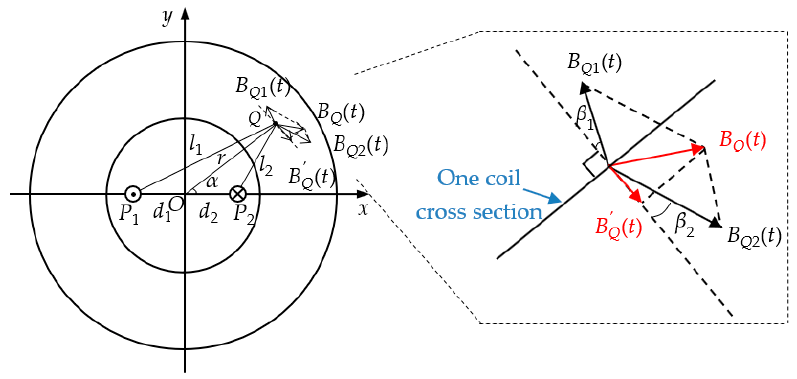
Figure 3. Schematic diagram of the secondary windings.